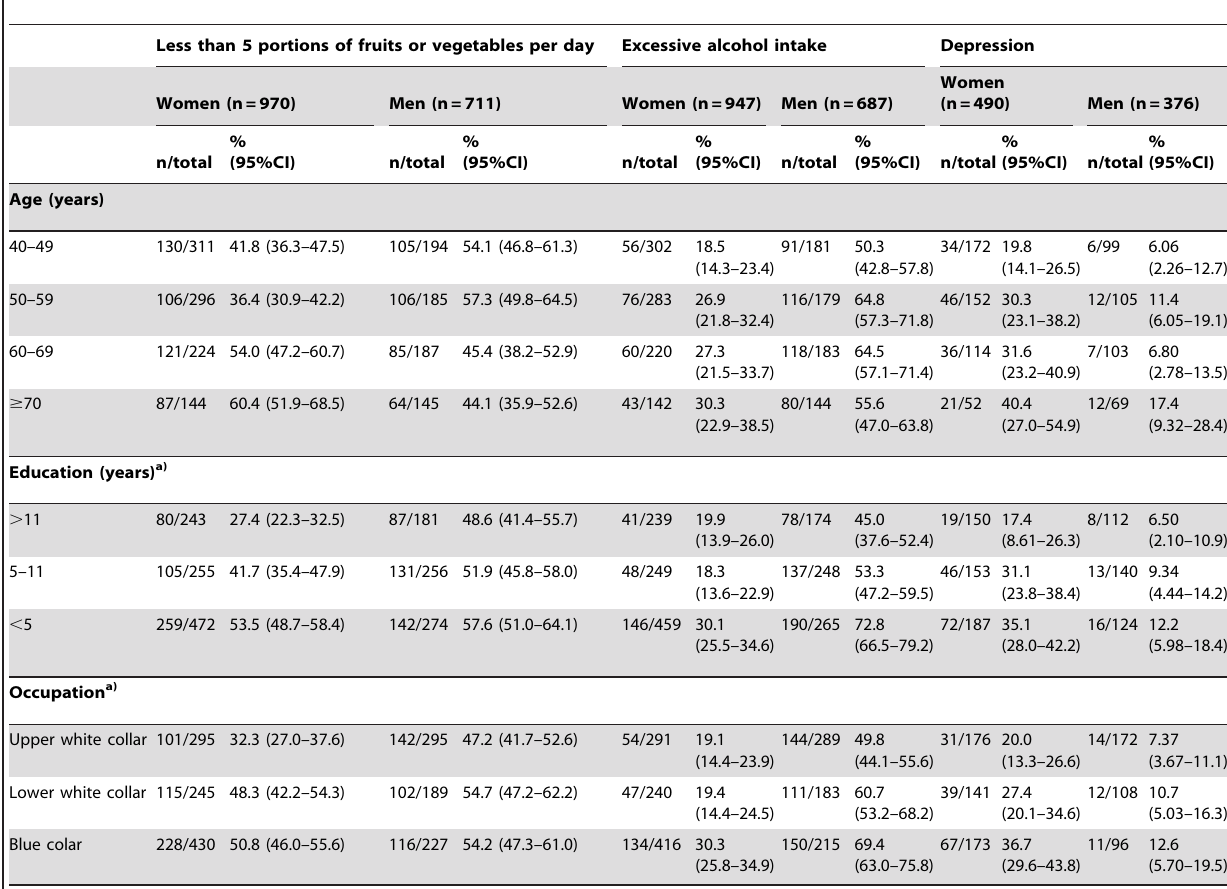
Table 4. Prevalence of low fruit and vegetable consumption, excessive alcohol intake and depression across age, education a) and occupation a)